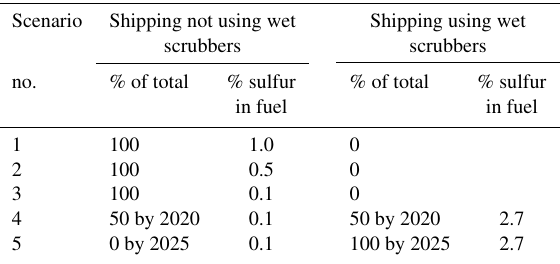
Table 2. Future scenarios that differ with respect to the sulfur con- tent of the fuel and scrubber